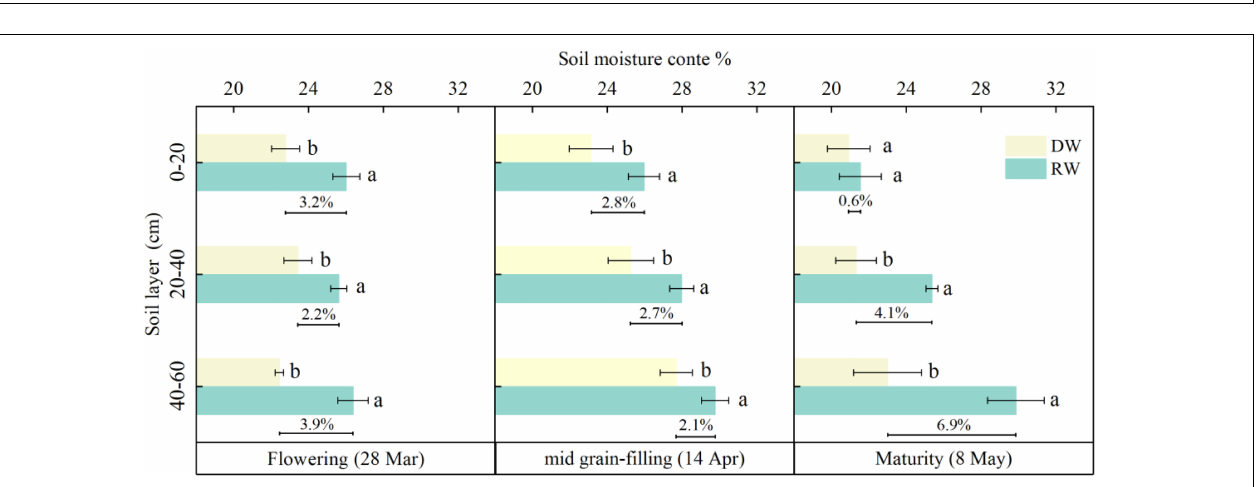
FIGURE 3 | Soil moisture content in different rotation wheat seasons in 2020–2021 (0–60 cm). Different lowercase letters indicate a significant difference ( P < 0.05) between dryland wheat vs. rice stubble wheat.